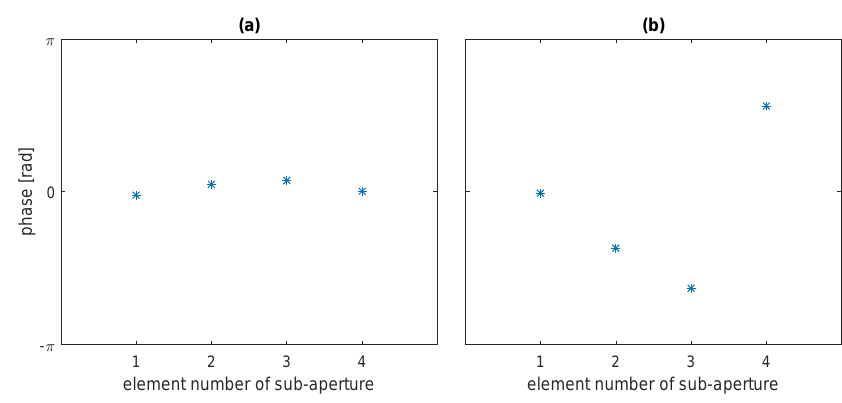
Figure 4. Phase of the signal obtained by each sub-aperture element ( a ) before and ( b ) after applying the adaptive weights.